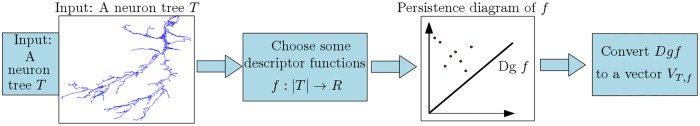
Pipeline of persistence-based feature vectorization framework.